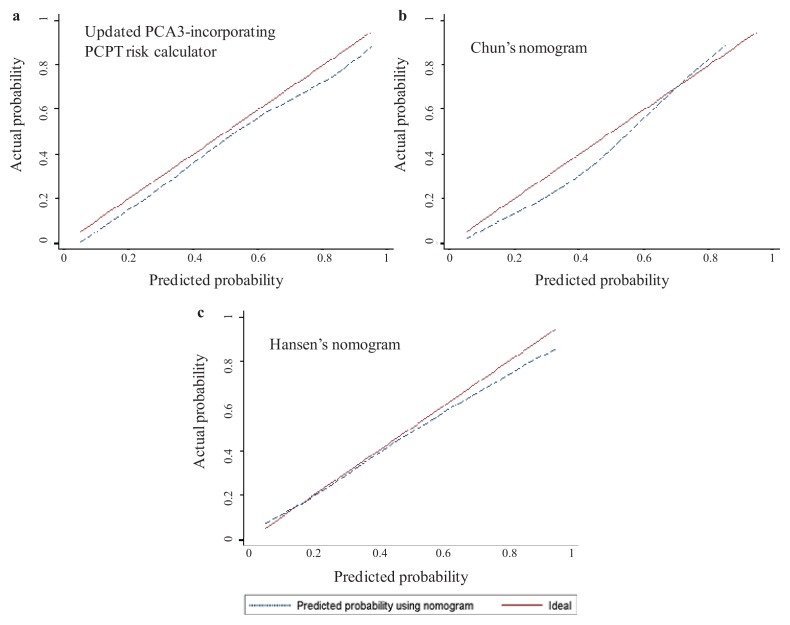
Calibration plots within external validation cohort using the three available urinary PCA3-based nomograms (n = 536 patients): (a) PCA3, including updated Prostate Cancer Prevention Trial risk calculator [20]; (b) Chun’s nomogram [21]; and (c) Hansen’s nomogram [14].